Question: What kind of plot is shown here?
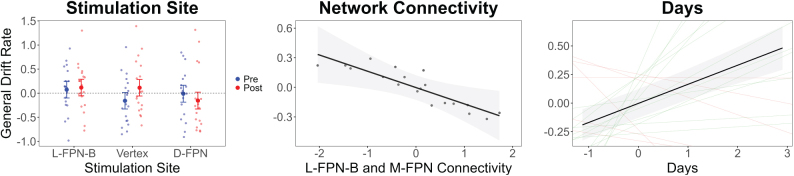
Answer: bar